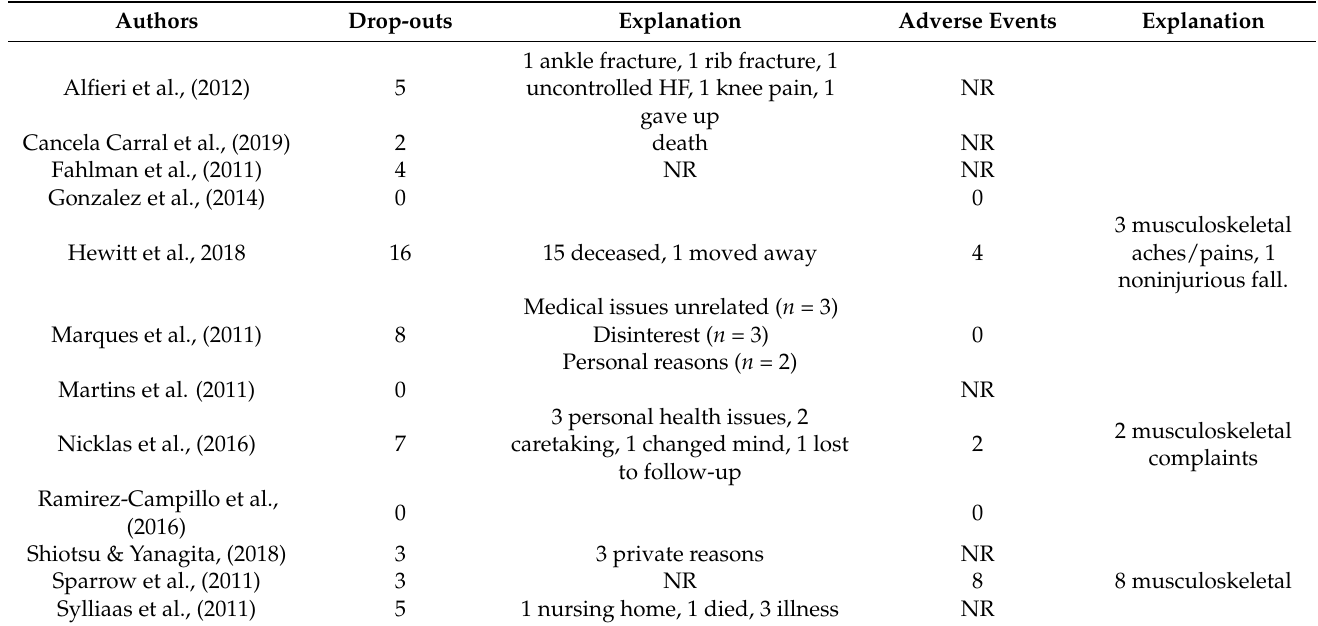
Table 4. Reported dropouts & adverse events.